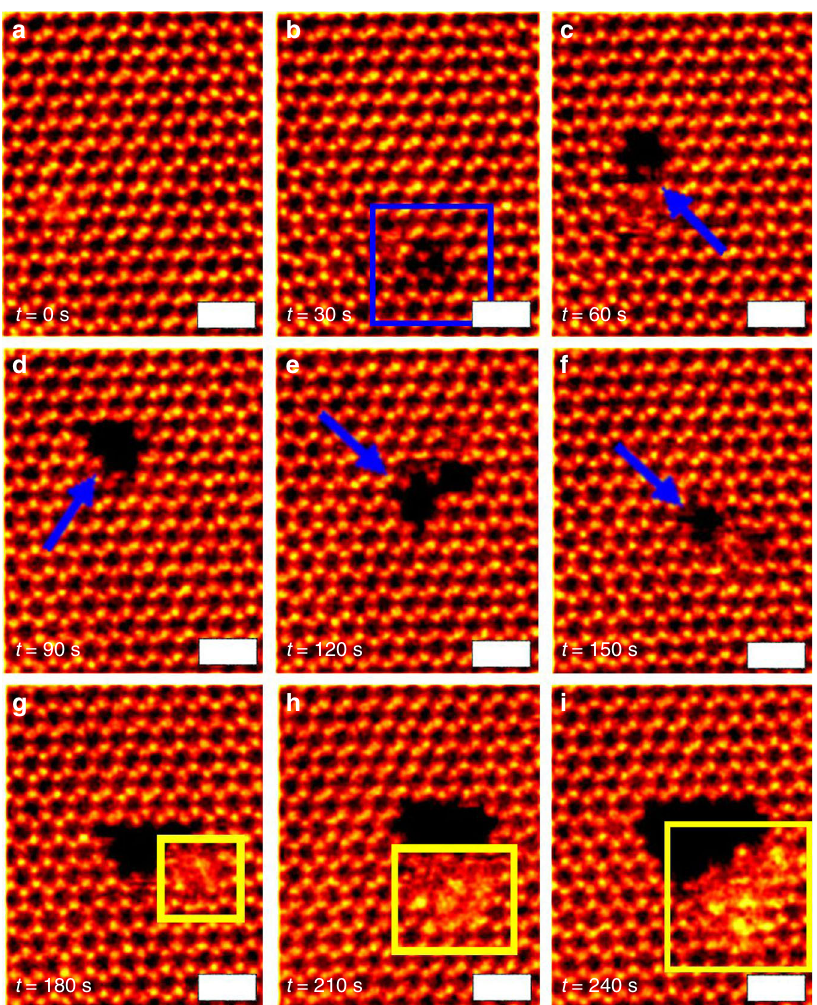
Fig. 9 Nanopore migration. a – i Time series of ADF-STEM images recorded of nanopores changing form, as well as migrating large distances within single- monolayer PbI 2 fl ake. The scale bar corresponds to 1